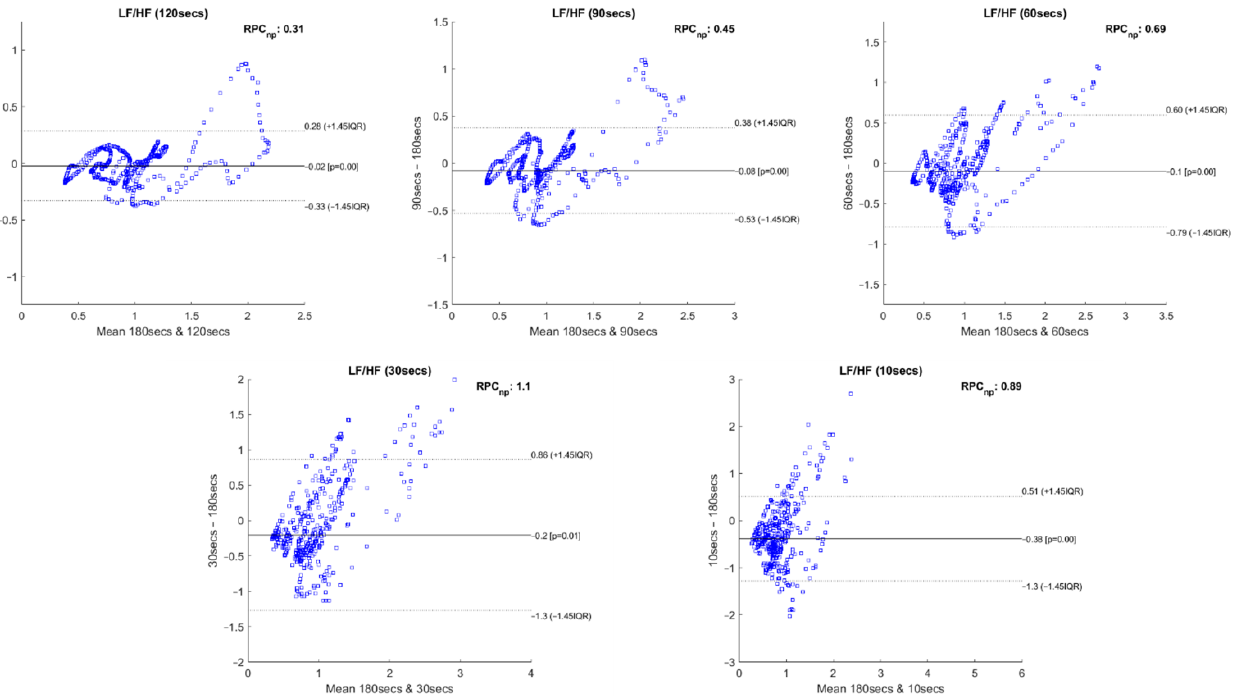
Figure 14. Bland–Altman plots of the LF/HF feature extracted with 120-, 90-, 60-, 30- and 10-second time frames compared to the LF/HF extracted with 180-second time frame, regarding a single experimental run of an individual subject .